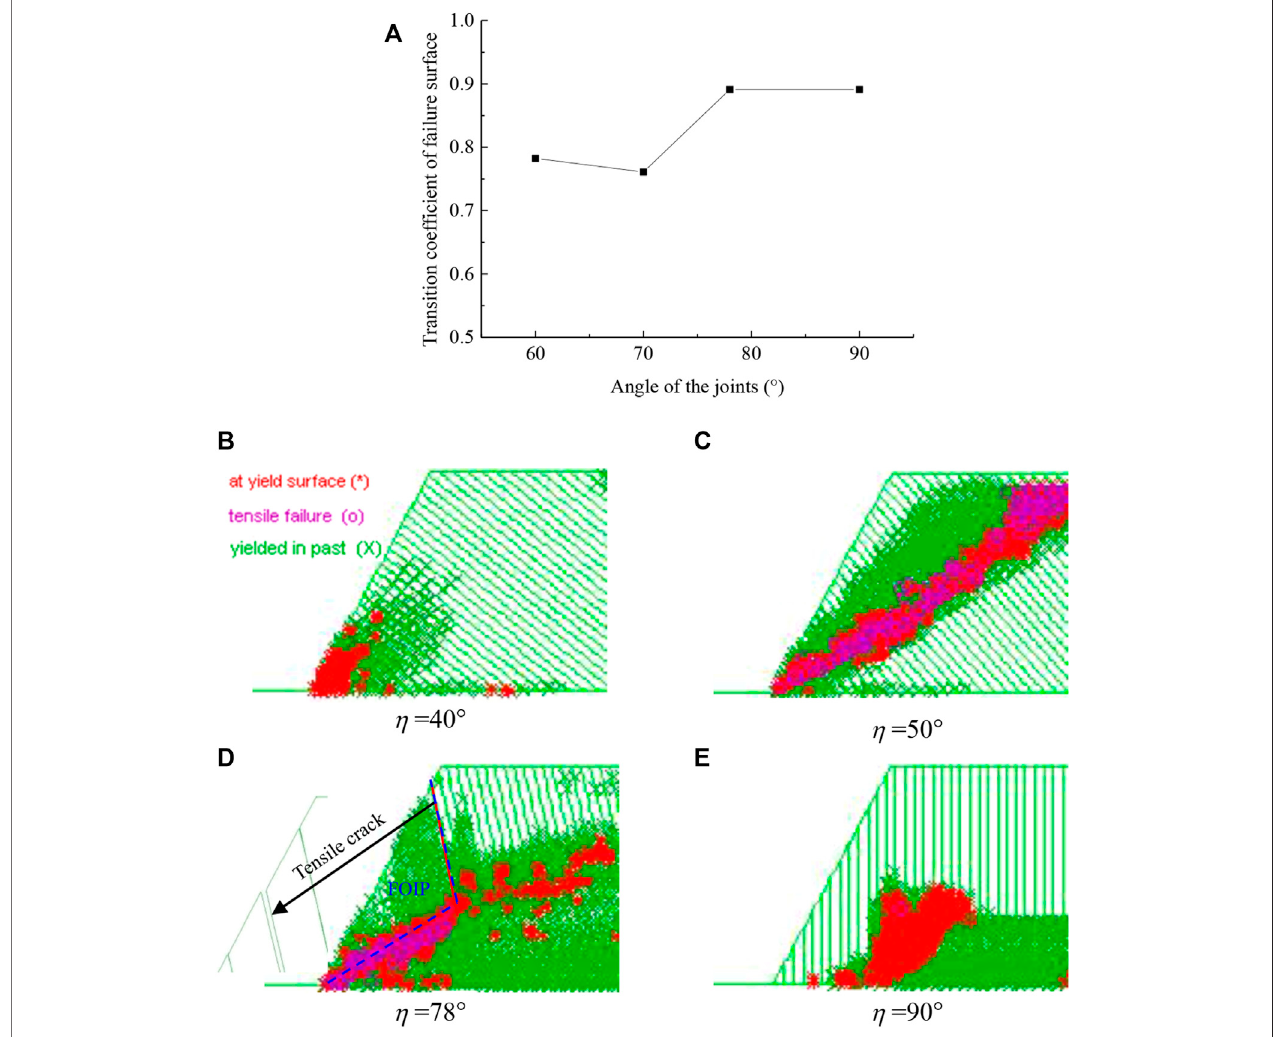
FIGURE 5 | Failure distribution of the slope for different joint angles ( η ). (A) : Relationship between the transition coef fi cient of failure surface and the joint angle; (B – E) : Plots show the simulated plastic zone for different joint angles.